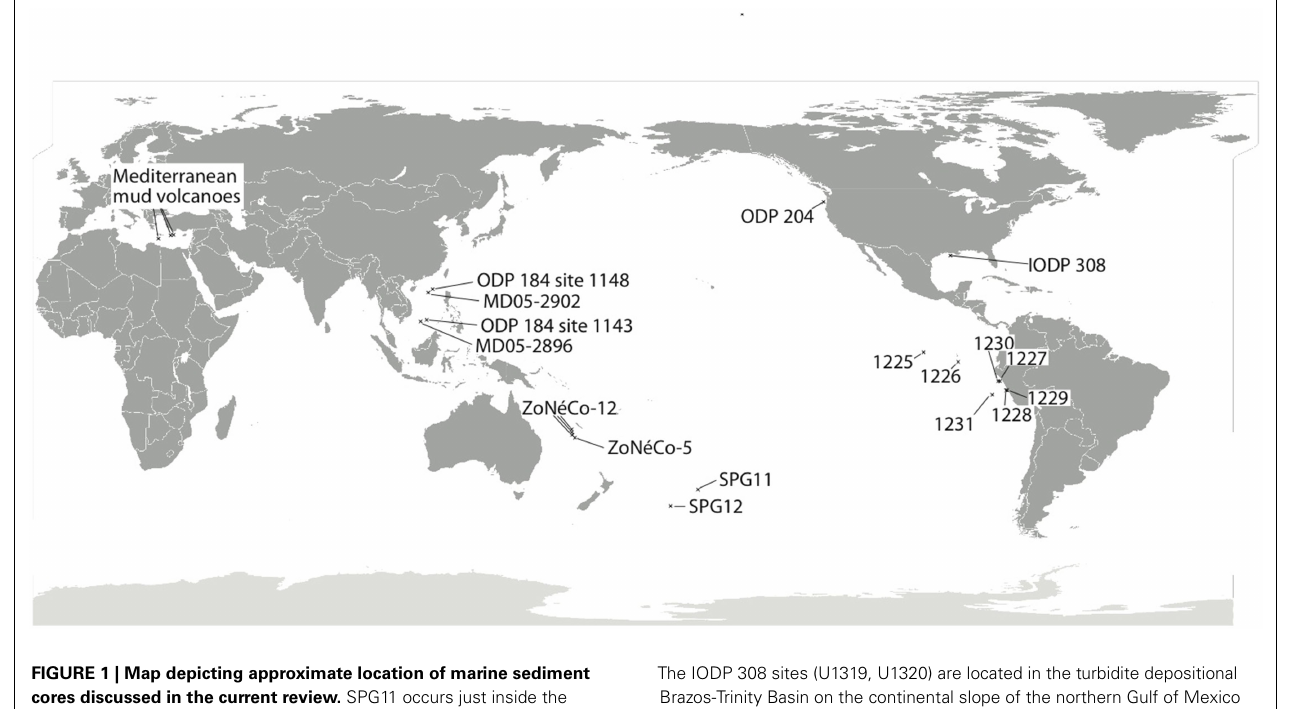
FIGURE 1 | Map depicting approximate location of marine sediment cores discussed in the current review. SPG11 occurs just inside the southern South Pacific Gyre, while SPG12 lies on the subtropical front separating the gyre from the Southern Ocean (D’Hondt et al., 2009). Sites MD05-2896 and MD05-2902 (Wang et al., 2010a) are from the South China Sea, with additional geochemical data on these sites sourced from nearby ODP Leg 184 Sites 1143 and 1148 (Shipboard Scientific Party, 2000a,b).The ZoNéCo-12 sites lie in the Fairway Basin in the Coral Sea (Roussel et al., 2009), with additional information from ZoNéCo-5 sites (Dickens et al., 2001).